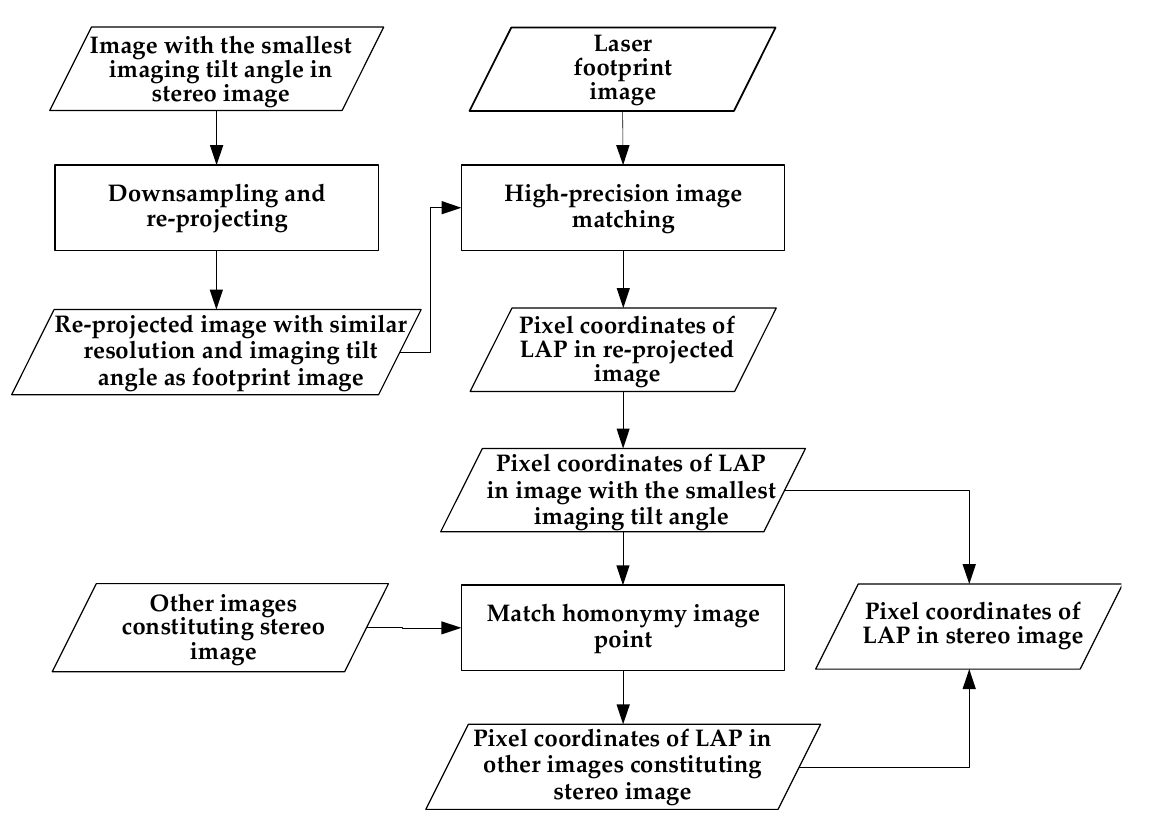
Figure 3. LAPs measurement using image matching between footprint image and stereo